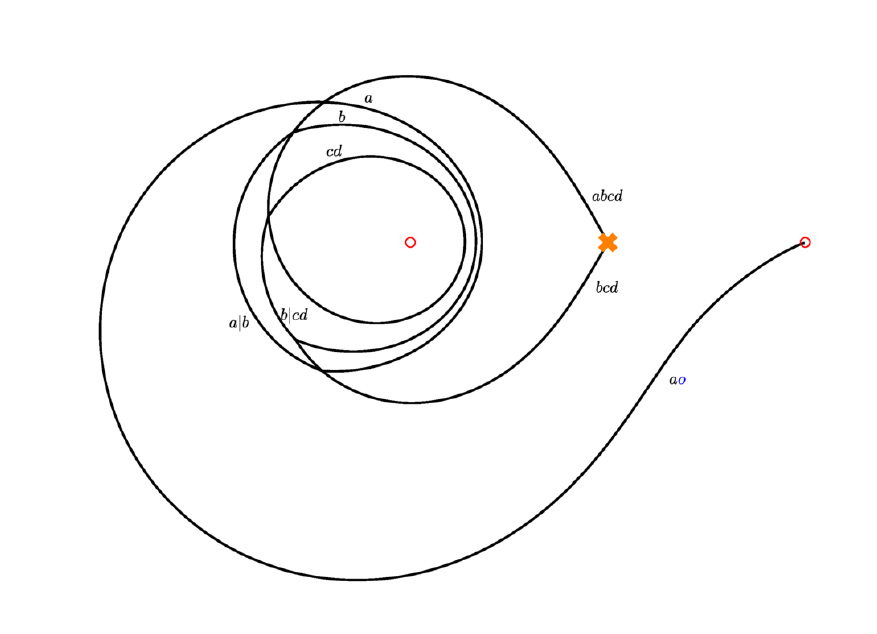
Figure 60. D4 + 4D0, \L" partition.